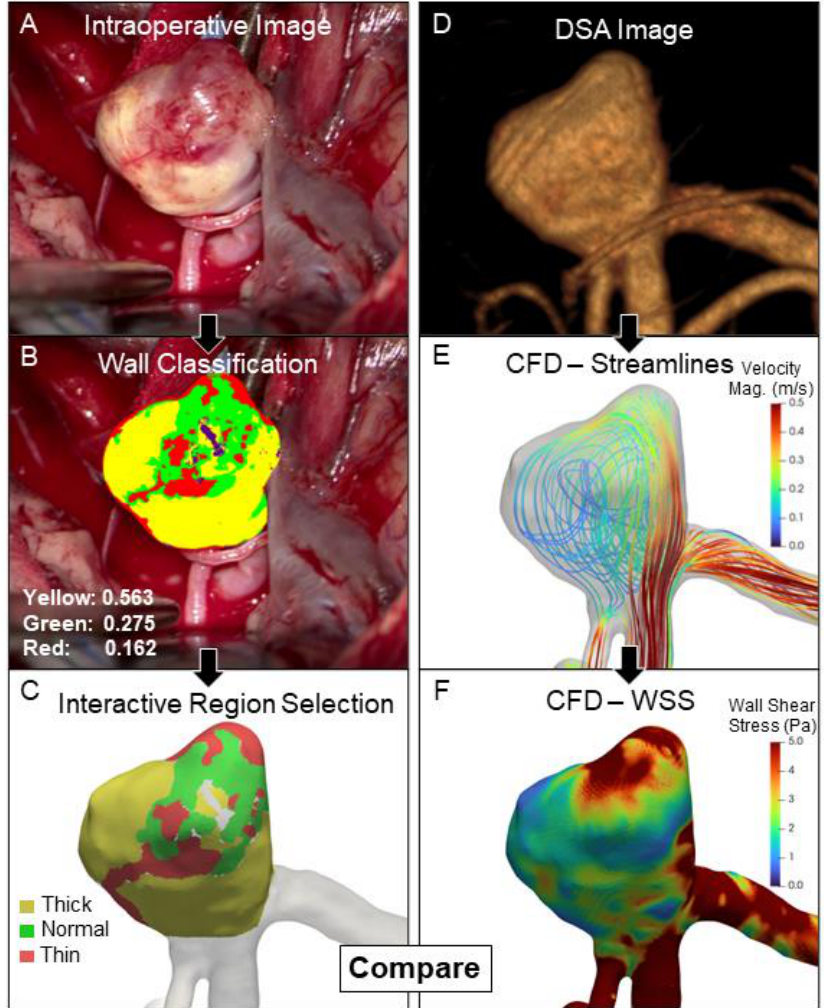
Figure 1. The overall workflow for exploring the relationship between hemodynamics and intraopera- tively observed wall type: A screenshot of the best view of the aneurysm from the video is obtained for further analysis ( A ). For the classification of different wall types, we used a machine-learning-based tool trained by a clinician. This gives a percentage of different areas marked by the clinician, as shown in the wall classification image ( B ). The different regions are then mapped onto the 3D surface ( C ). The DSA image is segmented and used for CFD analysis ( D , E ). The hemodynamic variables from the mapped regions are then exported for further statistical and regression analysis ( F ). Abbreviations: CFD = computational fluid dynamics, DSA = digital subtraction angiography, Mag. = magnitude, WSS = wall shear